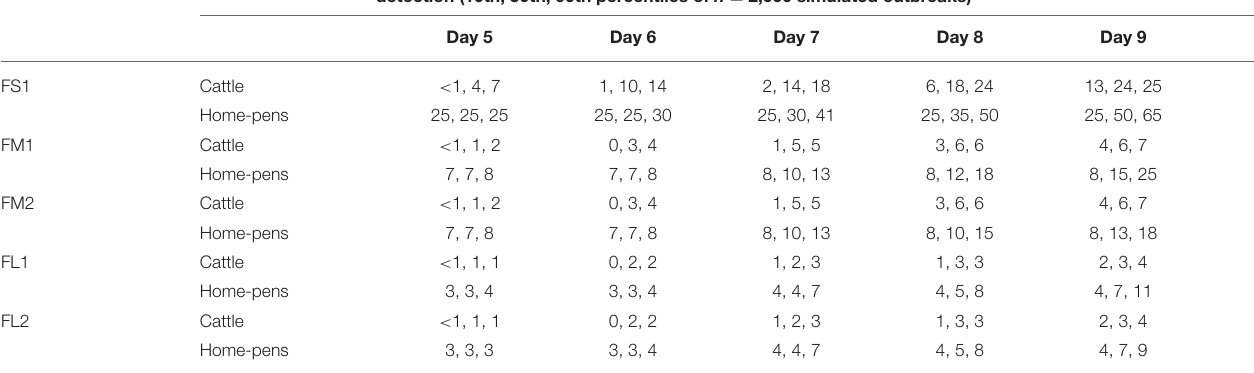
TABLE 3 | Estimated percentage of latent cattle and home-pens with latent cattle on a U.S. beef cattle feedlot depending on the outbreak detection day since foot-and-mouth disease introduction. Feedlot